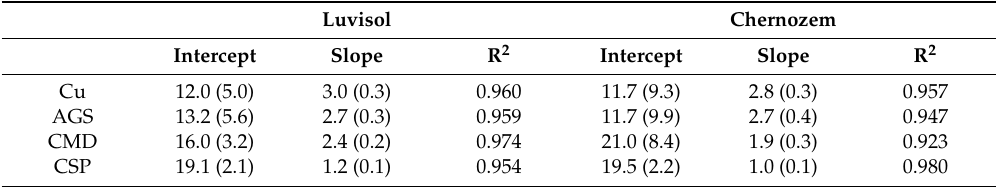
Figure 6. The regression analysis for Cu, AGS, CSP, CMD sensor elements response for combined data measured in soil types Luvisol and Chernozem. Table 2. Slopes and intercepts including their standard deviations (in brackets) estimated separately for various soils and sensor elements.